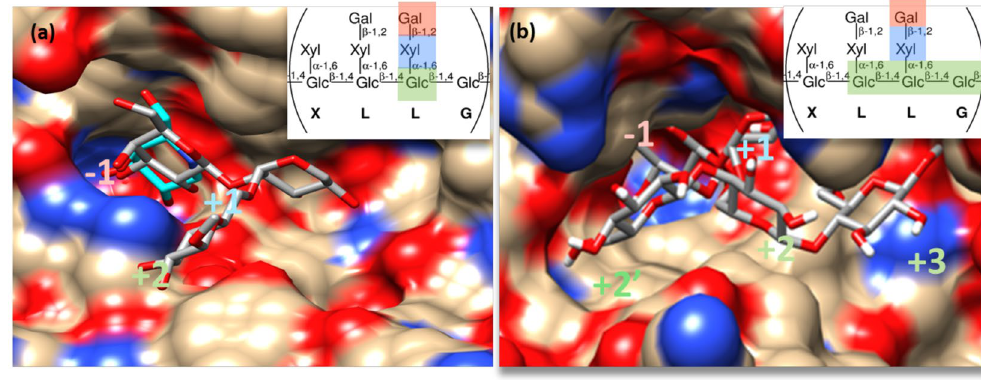
Figure 7. Docking of xyloglucan fragments against two β -galactosidases from different GH families. Best docked conformations following explorative search with xyloglucan fragments of different size against two different β -galactosidase structures: ( a ) xyloglucan side chain trisaccharide (GH35, PDB ID: 4DIJ); ( b ) branched xyloglucan side chain pentasaccharide (GH1, PDB ID: 1UWR). The different docked xyloglucan fragments are highlighted in color in the upper right corner. The colors reflect the putative enzyme carbohydrate residues whose corresponding subsites are depicted. The letters below the different residues of xyloglucan reflect the reference branch nomenclature for xyloglucan and derived